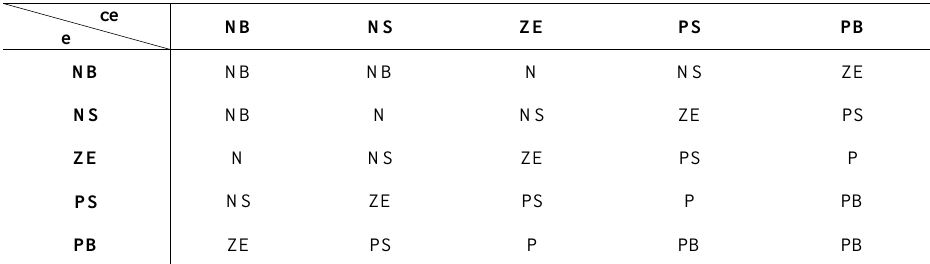
Table 2. FLC-sugeno control